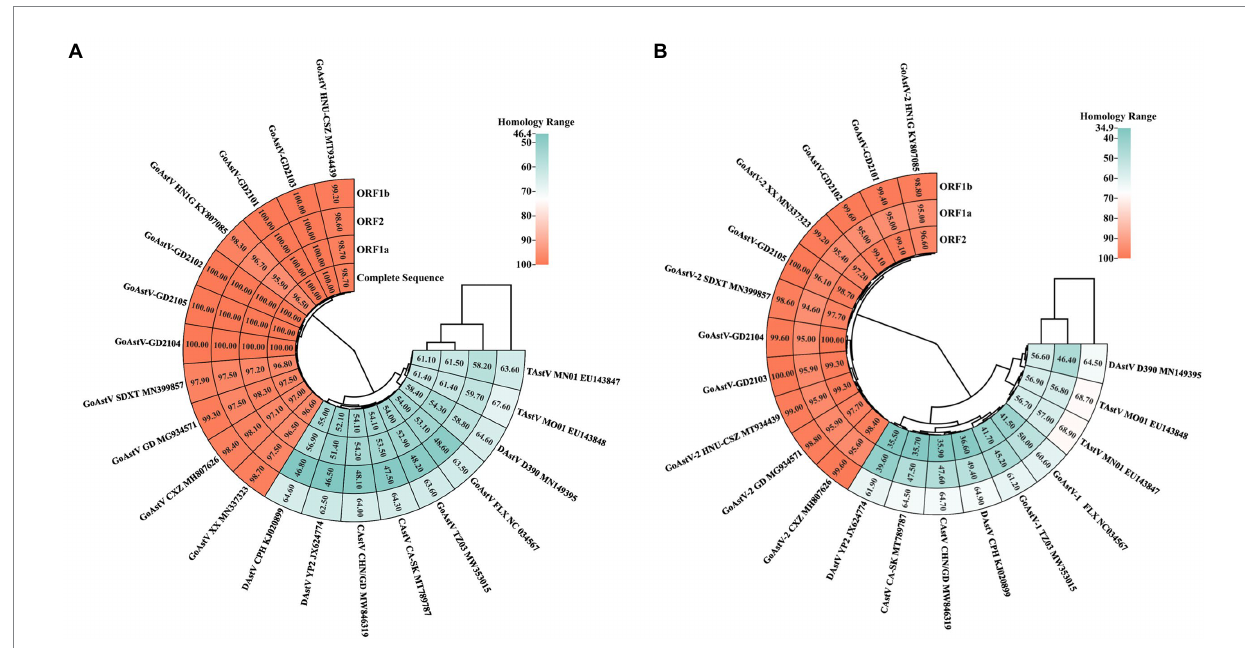
FIGURE 4 Sequence homology between five GoAstV isolates and other avian viruses. Nucleotide homology and amino acid homology among five GoAstV isolates and other species of Astroviruses were determined using the MegAlign software, and the heat map was later constructed on the website https://www.chiplot.online/. (A) Nucleotide homology. (B) Amino acid